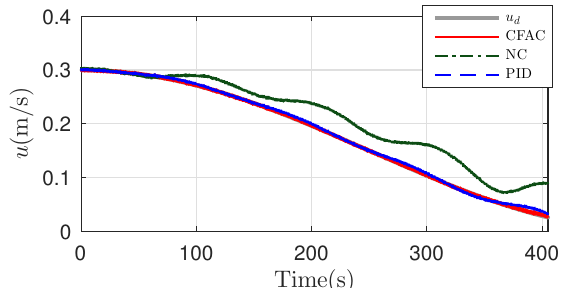
Figure 28. Velocity tracking performance in virtual mooring.